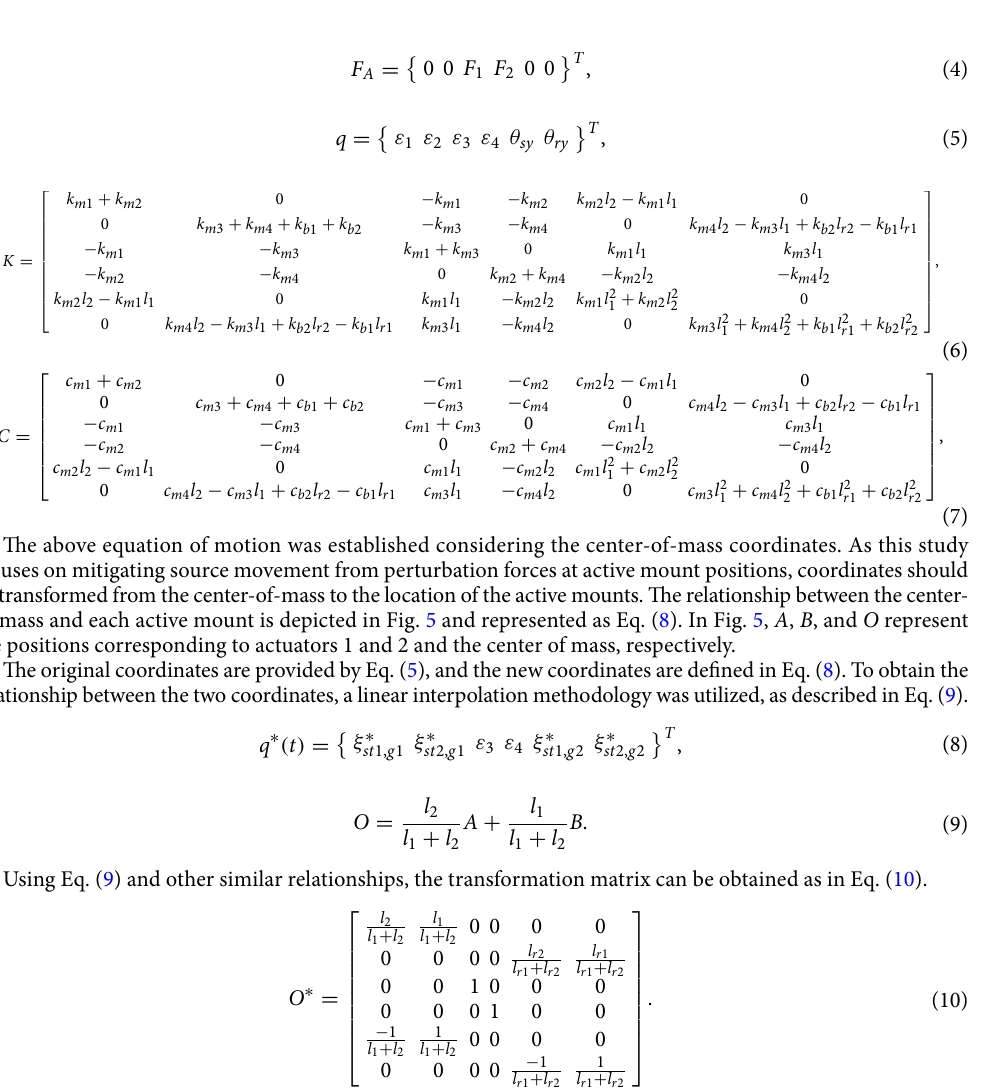
Control force and phase for vibration isolation. The relative phase between the harmonic force and system motion plays an important role when considering the relationship between them. To manage the phase along with the amplitude, the disturbance and control forces are assumed to be complex values. It is defined through Eqs. (12) and (13).